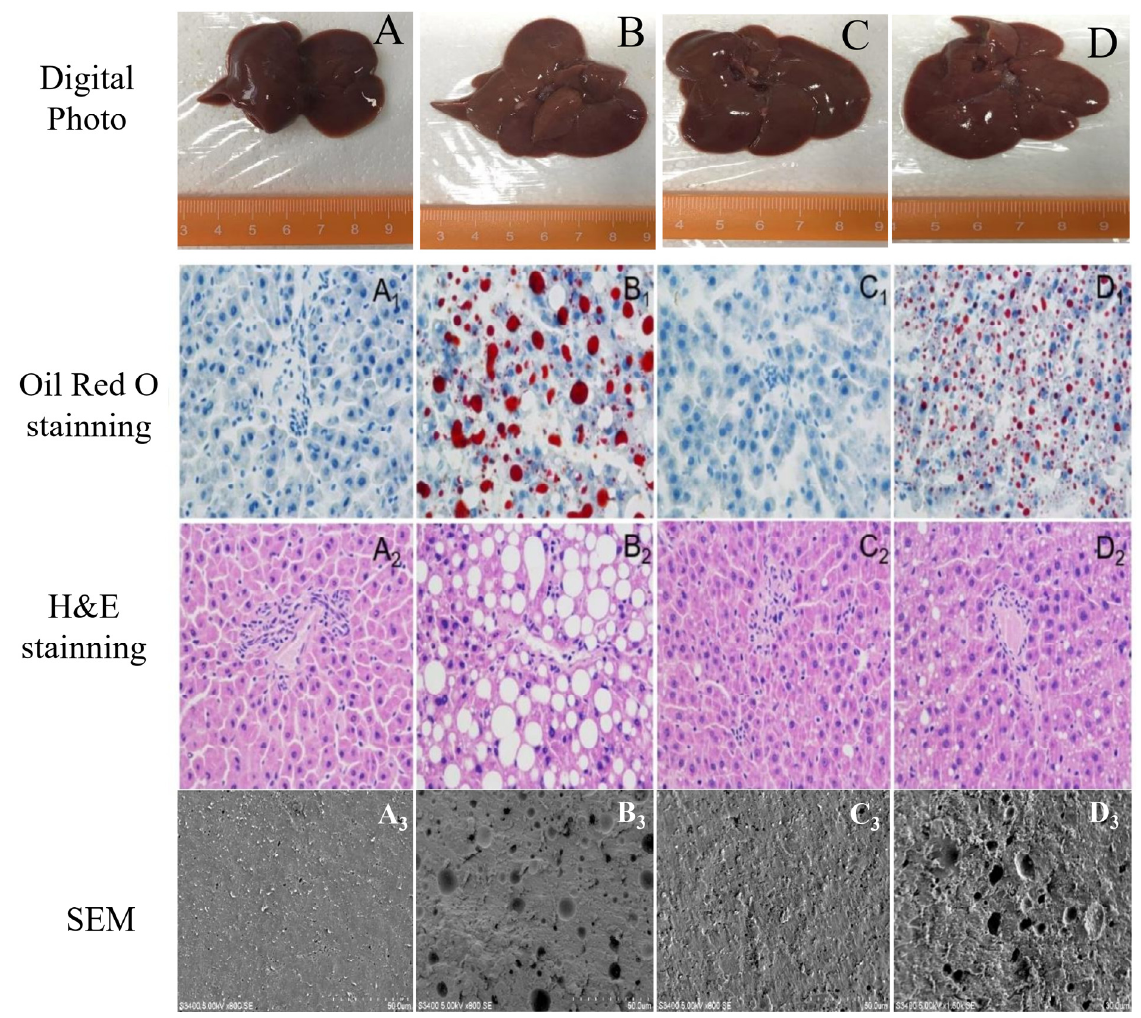
Figure 1. Histopathological alterations in the abdominal fat pad and liver of rats. ( A ): Control group; ( B ): model group; ( C ): EP group; ( D ): SP group. An HFD containing 2% egg PLs (egg yolk phospholipids group, EP), and an HFD containing 2% soy PLs (soybean phospholipids group, SP). The SEM represented Scanning electron microscope.